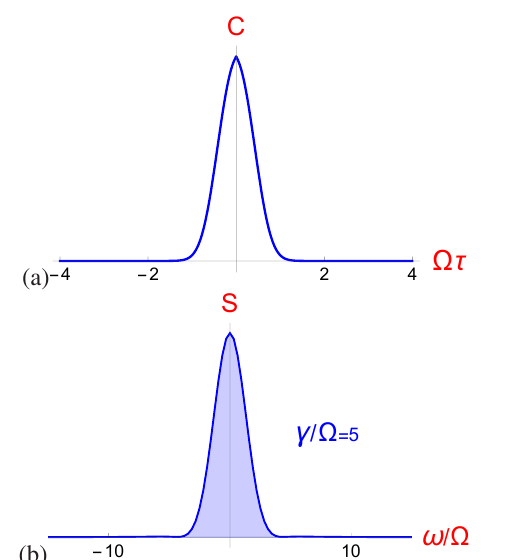
! L , for large damping, −